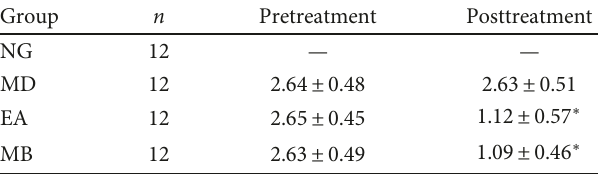
Table 2: Comparison of DAI in each group (mean ± SD). Group n